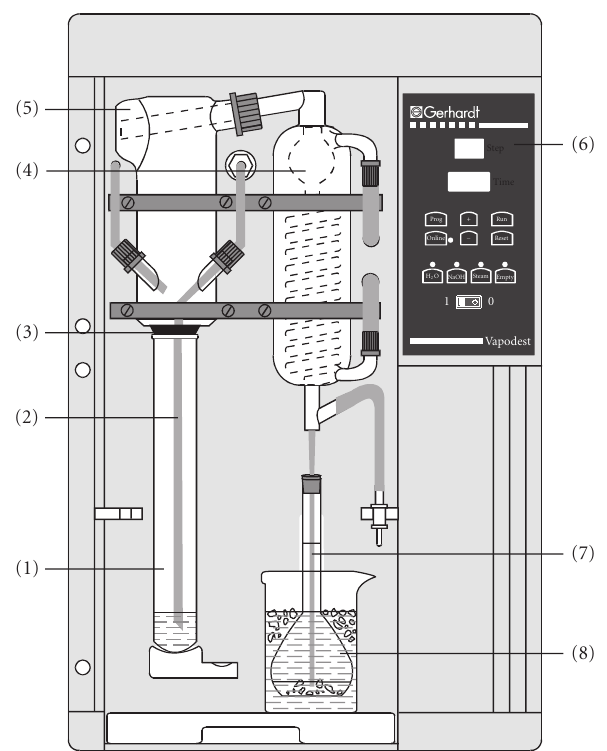
Figure 3: Automated steam distillation device for the determi- nation of formaldehyde in alcoholic beverages: (1) Kjeldatherm digestion tube with acidified sample, (2) steam inlet tubing, (3) Viton-cone, (4) distillation condenser cooled at 1 ◦ C, (5) distribution head, (6) keyboard and display, (7) distillate outlet tubing, and (8) cooled graduated flask as receiver containing ice and sulfuric acid (25%), in which the outlet tubing must be submerged to avoid